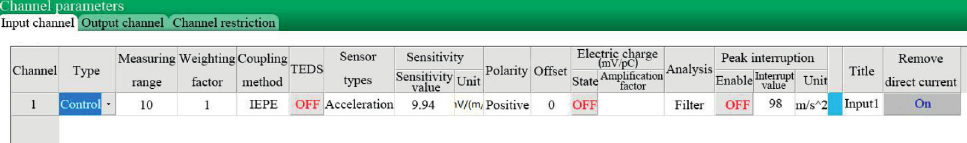
Figure 22: Setting the channel parameters.